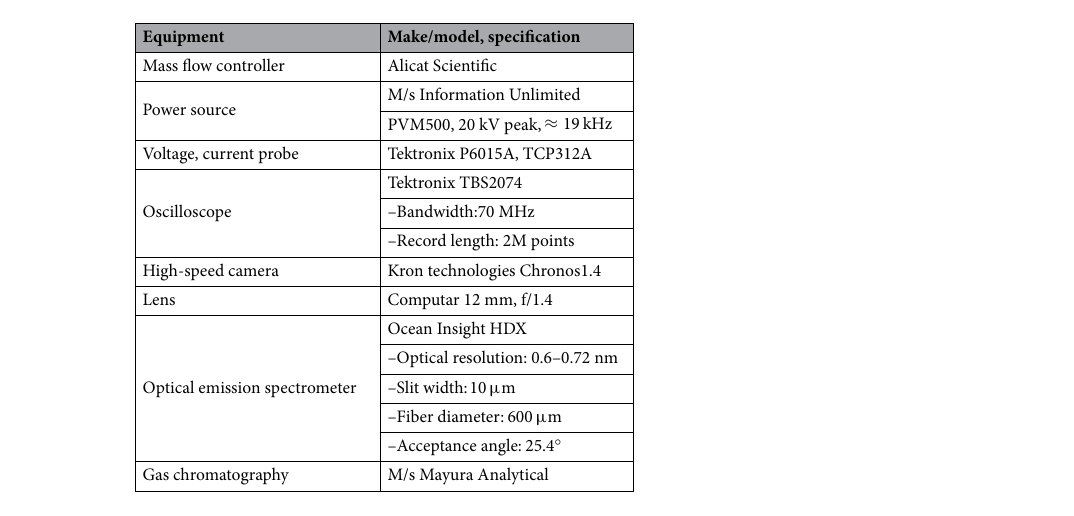
Table 1. Details of the equipment used in the diagnostic setup.